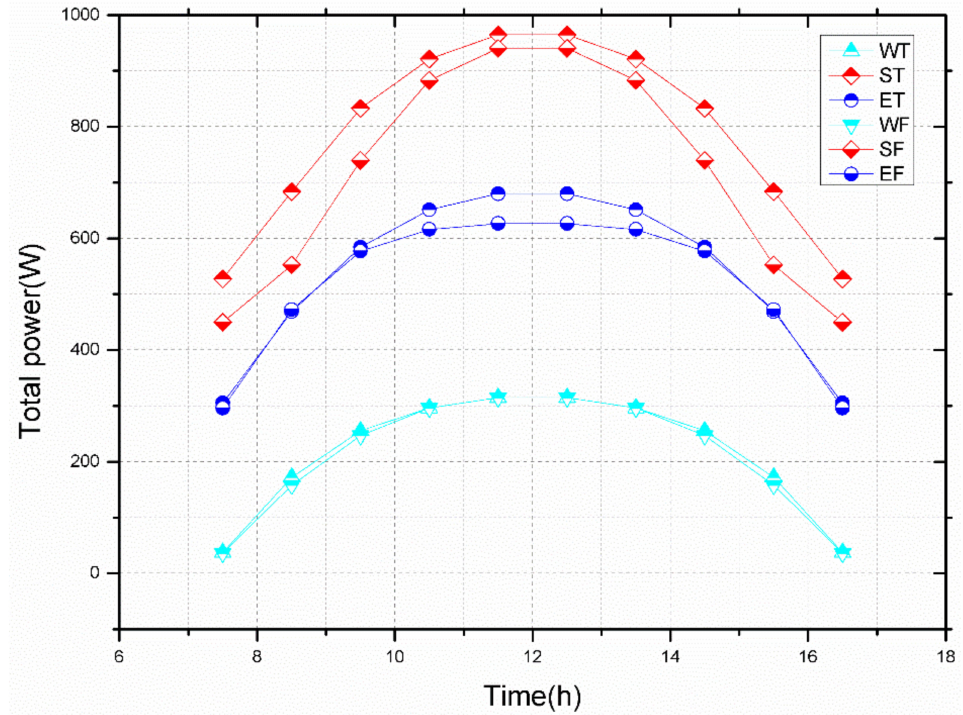
Figure 8. Variation in the total generated power E sum of the single-module system with